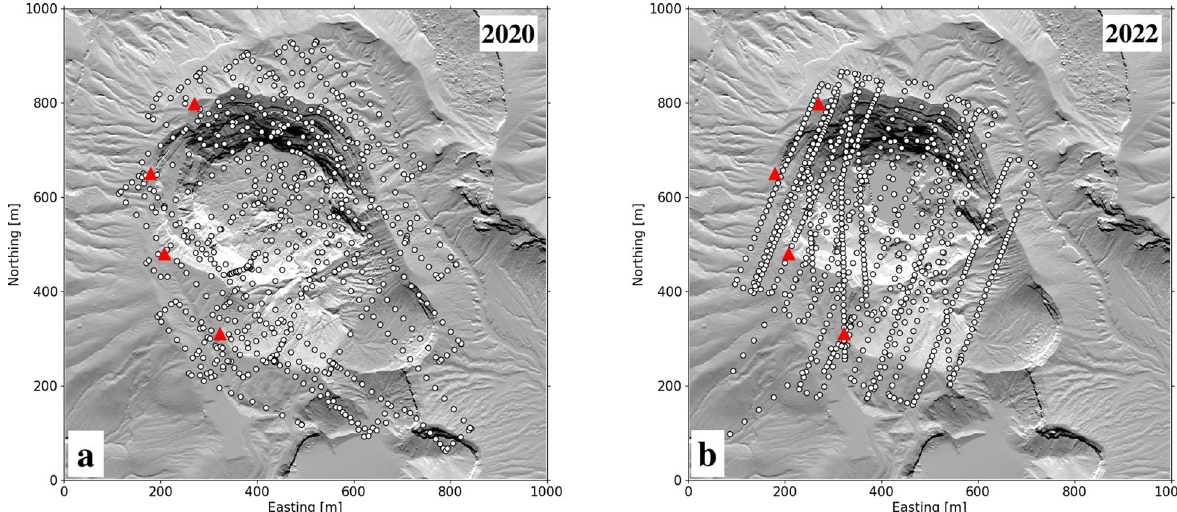
Fig. 2 UAV camera positions for the a 2020 and b 2022 surveys. The background topography is the DEM created in this study. The white open circles are the camera positions. The red triangles indicate the positions of the